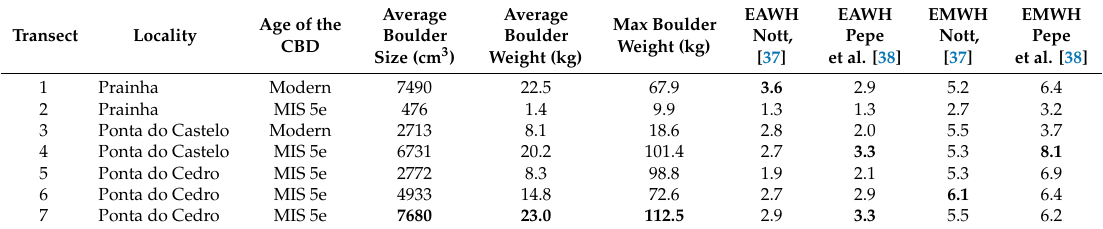
Table 8. Summary data from Tables 1–7, showing maximum boulder size and estimated weight compared to the average values for all boulders (n = 25) from each of transects 1–7 together with calculated values for wave heights estimated as necessary for boulder mobility. Estimated average wave height (EAWH; in meters) and estimated maximum wave height (EMWH; in meters), calculated according to equations derived by Nott [37] and Pepe et al. [38]. (see the methods Section 3.2. (hydraulic model)). Maximum values for each Transect in